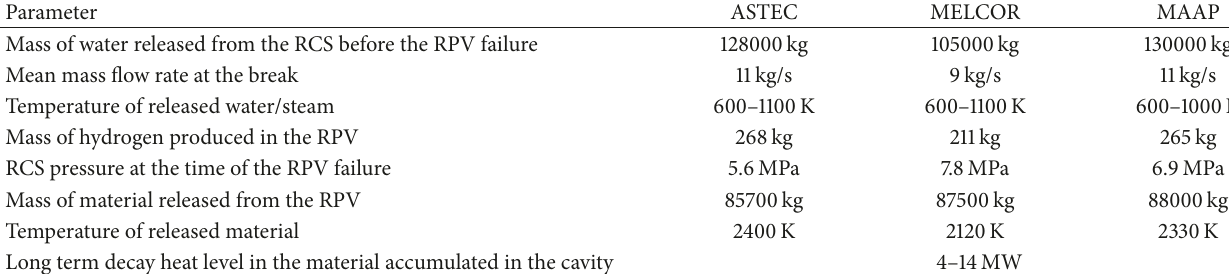
Table 2: Main results of the in-vessel severe accident analysis important for the latter containment behaviour.